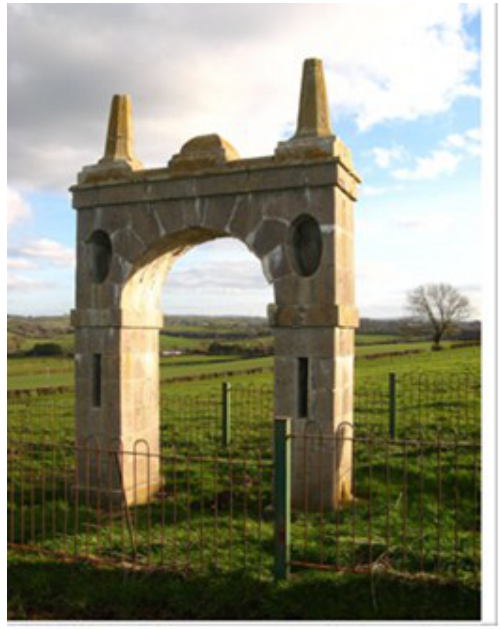
Figure 5: The Meridian Mark at Tullyard for the Transit Instrument from the north-west.